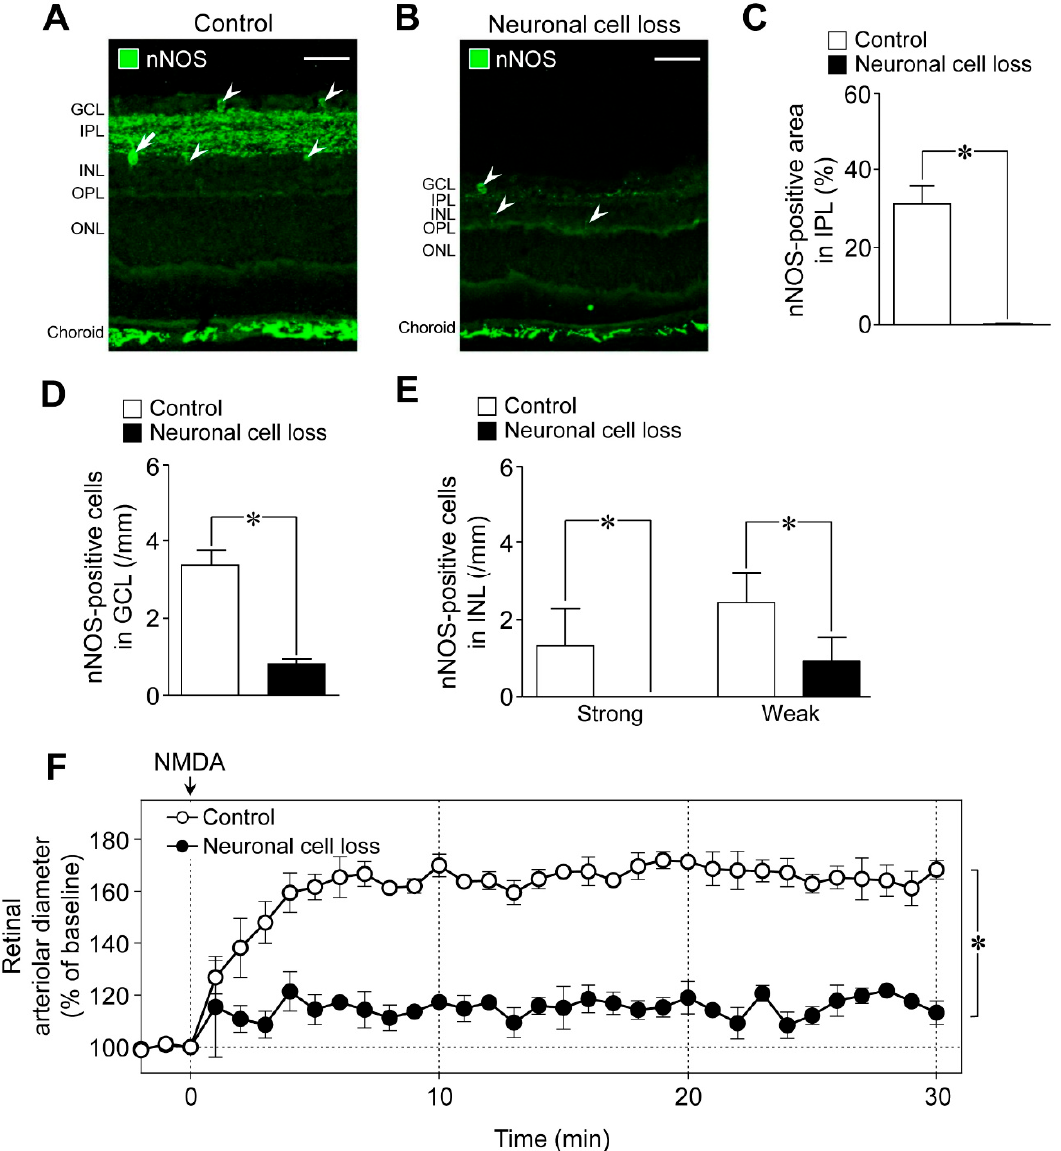
Figure 4. Effects of loss of inner retinal neurons on the number of neuronal NO synthase (nNOS)-positive cells and the retinal vasodilation induced by intravitreal injection of NMDA. ( A , B ) Confocal microscopy images of retinal cross-sections labeled with ( A ) anti-nNOS antibodies from control ( B ) and neuronal cell loss model. Arrows and arrowheads indicate nNOS-positive cells with strong and weak immunoreactivities, respectively. Scale bars: ( A , B ) 50 μ m. ( C – E ): Quantification of ( C ) nNOS-positive area ( D , E ) and cell number. Each column with a vertical bar represents the mean ± SE from five animals. * p < 0.05. ( F ) Changes in the retinal arteriolar diameter induced by intravitreal injection of NMDA (6 nmol) in control and neuronal cell loss model. Each point with a vertical bar represents the mean ± SE from four animals. * p < 0.05. GCL, ganglion cell layer; IPL, inner plexiform layer; INL, inner nuclear layer; OPL, outer plexiform layer; ONL, outer nuclear layer.